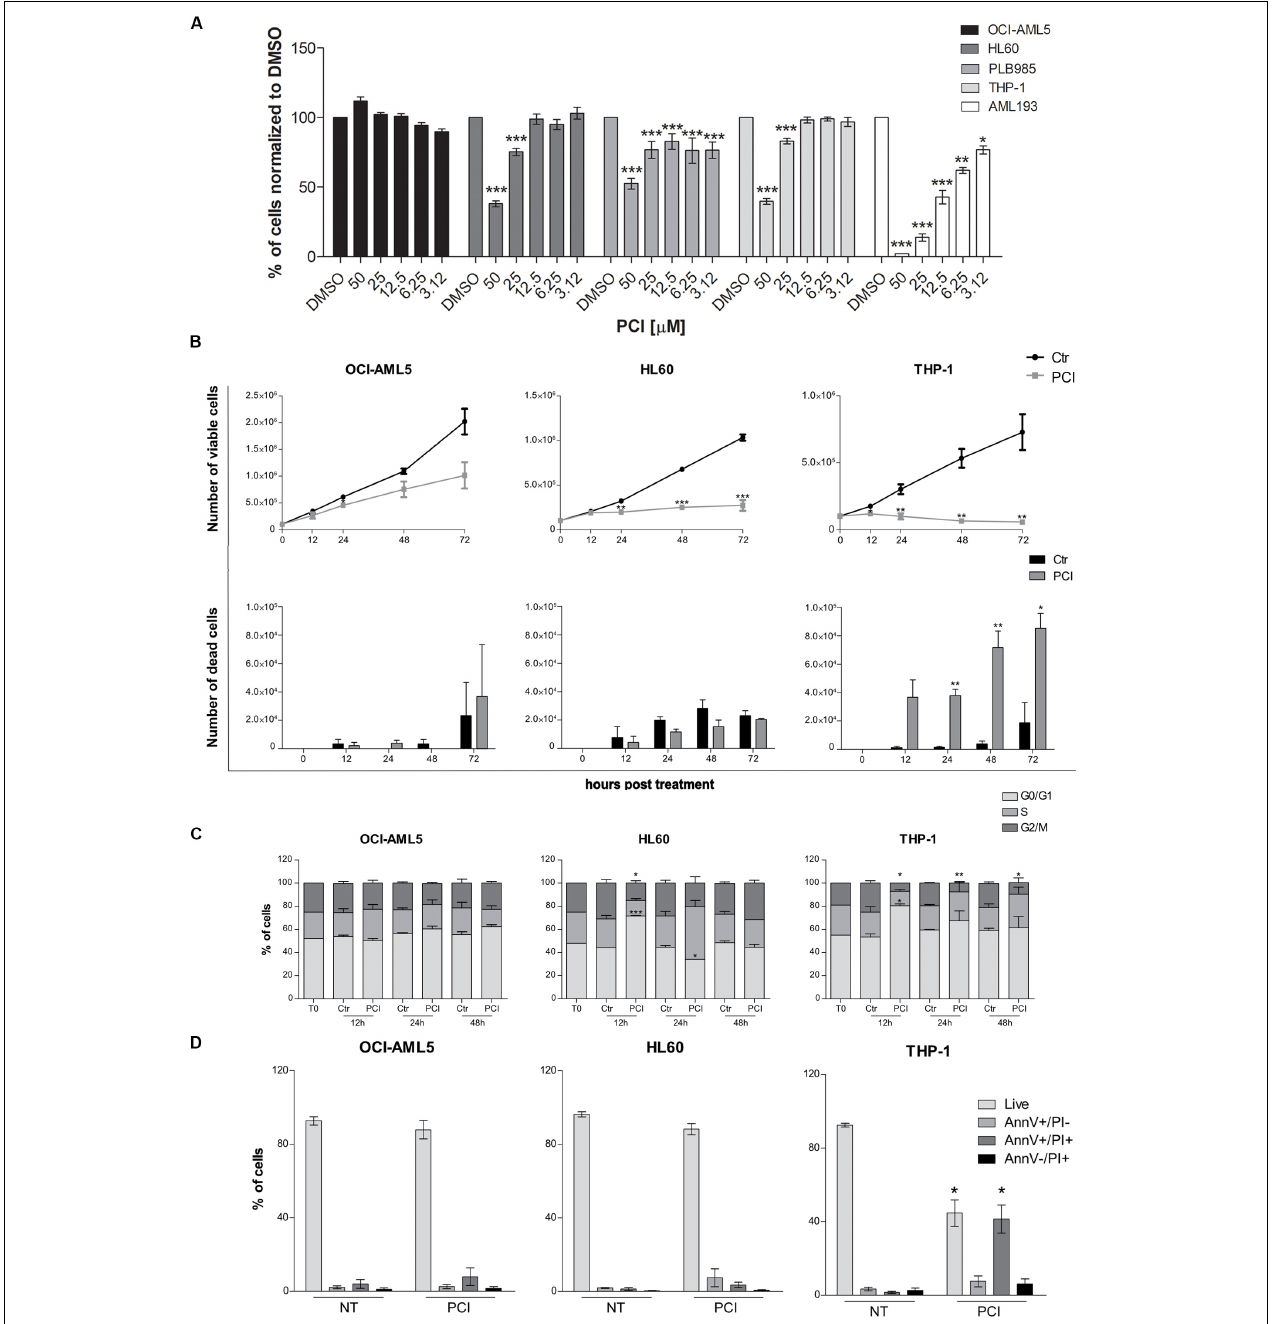
FIGURE 2 | Cytostatic and cytotoxic effect of PCI in AML cell lines. (A) The indicated cell lines were treated for 72 h with different concentration of PCI, or DMSO alone as a control. CTG assay was used to assess the effect of the treatment on the cell viability. The results are presented as mean ± SD from four technical replicates deriving from one independent experiment for PLB985 and AML193 cell lines, and at least two independent experiments for OCI-AML5, HL60, and THP-1 cell lines. (B) Effect of PCI on AML cell line growth. Cells were treated with 50 µ M of PCI or with DMSO as a control. Cell viability (upper panel) and cell death (lower panel) were determined 12, 24, 48, and 72 h after treatment using trypan blue staining. The results are presented as mean ± SEM from two independent experiments for 12 h and three independent experiments for the others time points. (C) Cell cycle time course over 48 h of PCI treatment. Cells were treated with 50 µ M of PCI or with DMSO as a control. Histogram showing cell distribution in three different cell cycle phases indicated as diverse shades of gray. The results are presented as mean ± SEM from two independent experiments. (D) Induction of apoptosis upon 72 h of PCI treatment. Cells were treated with 50 µ M of PCI or with DMSO as a control. Histogram showing the percentage of live, AnnV+/PI, AnnV+/PI+ and AnnV–/PI+ cells indicated as diverse shades of gray. The results are presented as mean ± SEM from three independent experiments. NT, untreated; T0, time zero; AnnV, annexin V; PI, propidium iodide. * p < 0.05, ** p < 0.01, *** p < 0.001, Student’s t